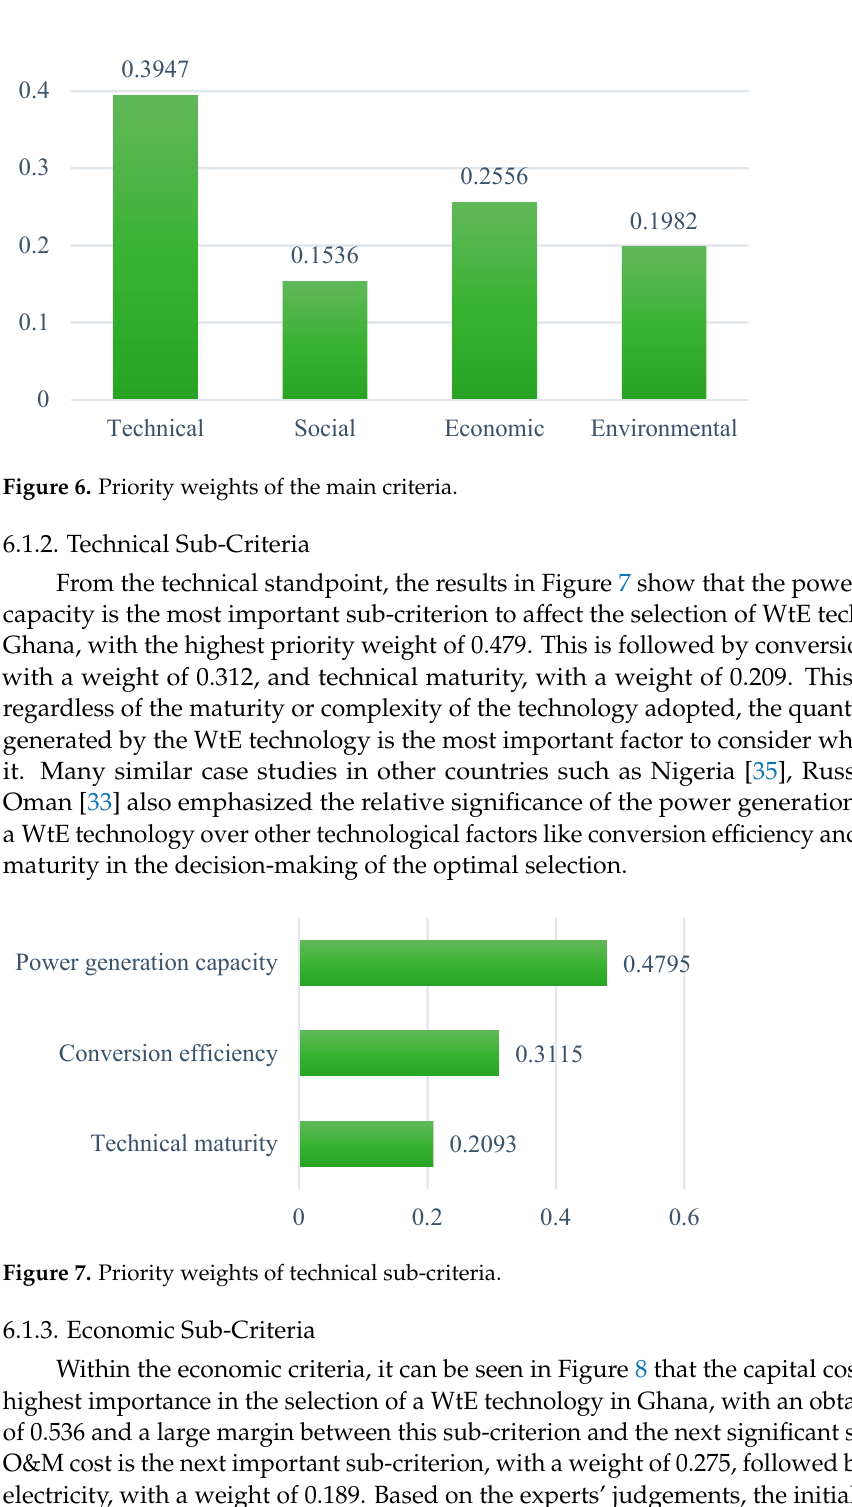
Figure 7. Priority weights of technical sub-criteria.